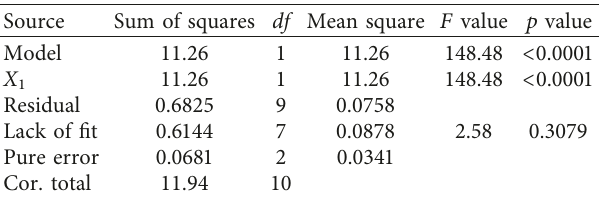
1 and X 2 on the response variable R 2 Table 8: Analysis of variance for a simplified model for response variable R 1 .